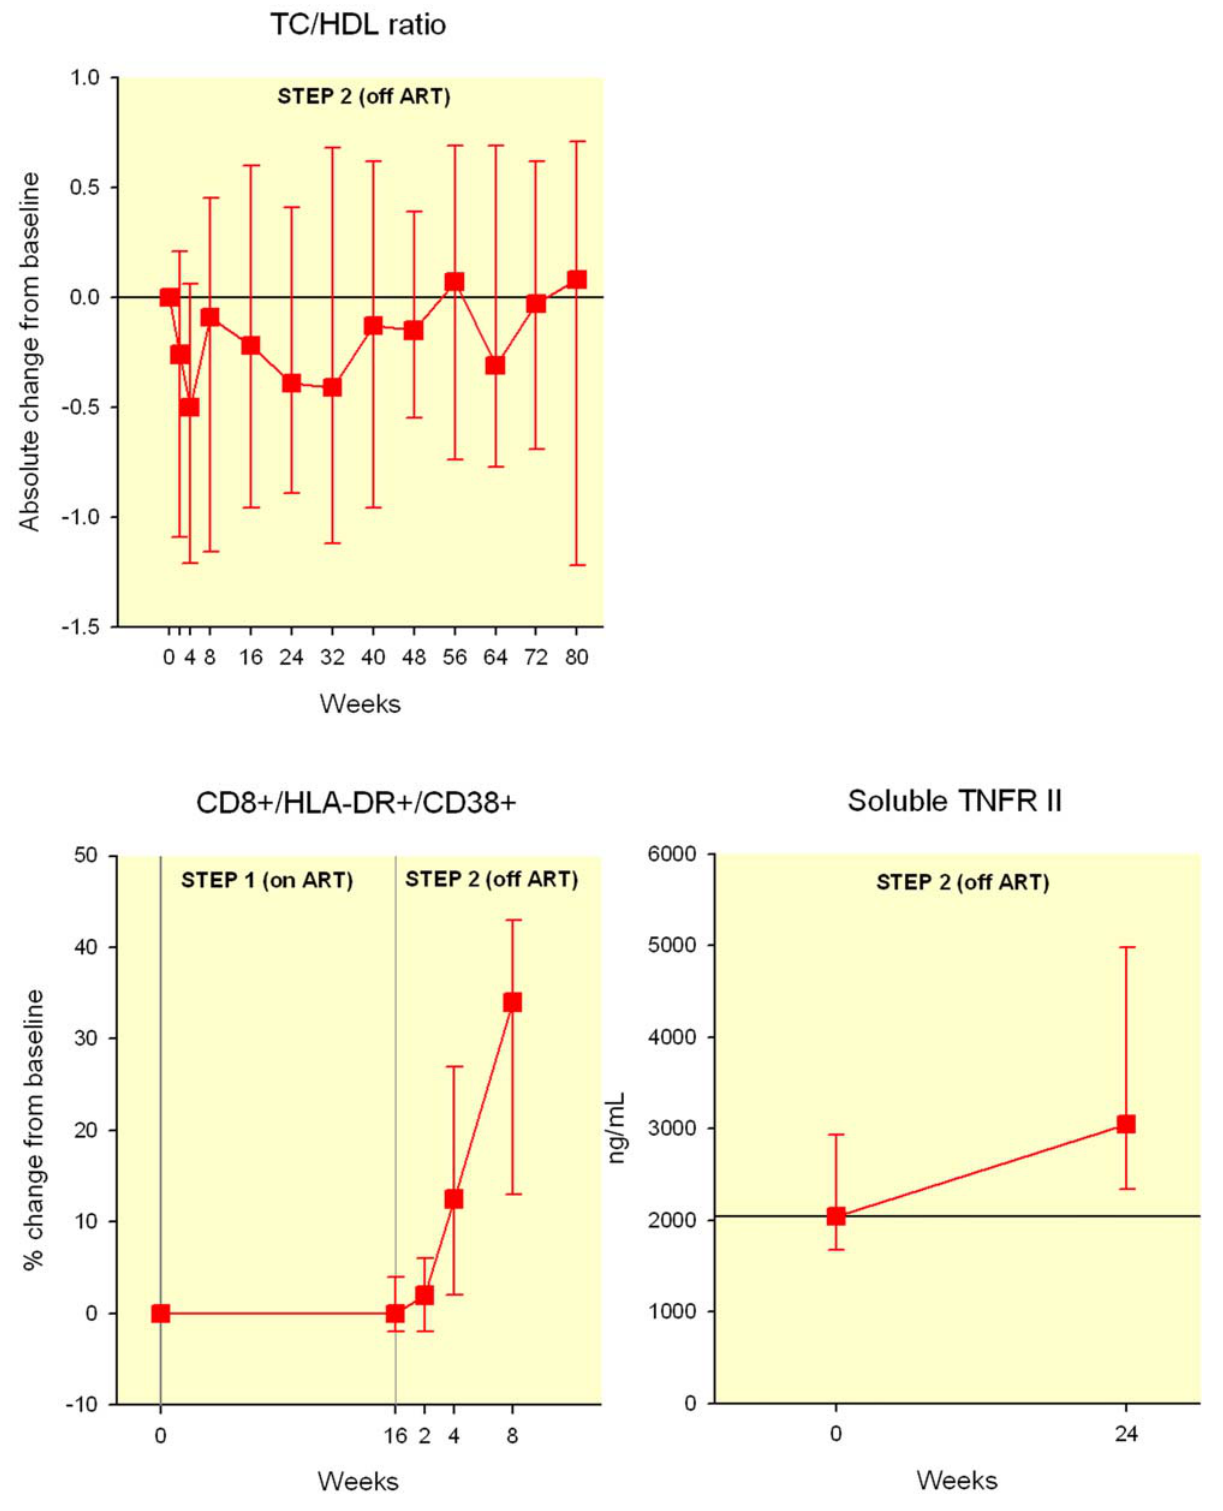
Figure 3. Total cholesterol to HDL ratio changes overtime after treatment interruption (median change and IQR). Percentage change of CD8 + /HLA-DR + /CD38 + cells after TI. (median and IQR) Absolute change in soluble serum TNR II levels (median and IQR) Individuals were censored after reinitiating antiretroviral therapy, thus the decreasing N in the figures.